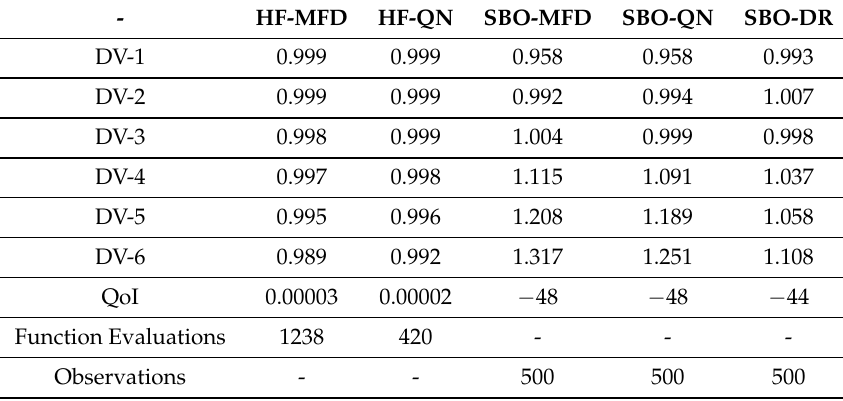
Table 1. Outcome of the optimization study of the high-dimensional Rosenbrock function. In the table, observations refer to the number of experiments used to construct the surrogate. Note that the same starting point ( x = 0) was used for all the design variables in the gradient-based optimization studies. In the table, DV stands for design variable, HF stands for high-fidelity simulations, SBO stands for surrogate-based optimization, MFD stands for method of feasible directions, QN stands for quasi-Newton BFGS method, and DR stands for division of rectangles derivative-free method. - HF-MFD HF-QN SBO-MFD SBO-QN SBO-DR DV-1 0.999